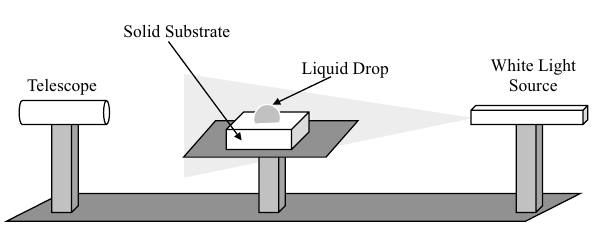
Fig. 2 Sketch shows a telescope-goniometer technique for contact angle measurement (Salim et al.